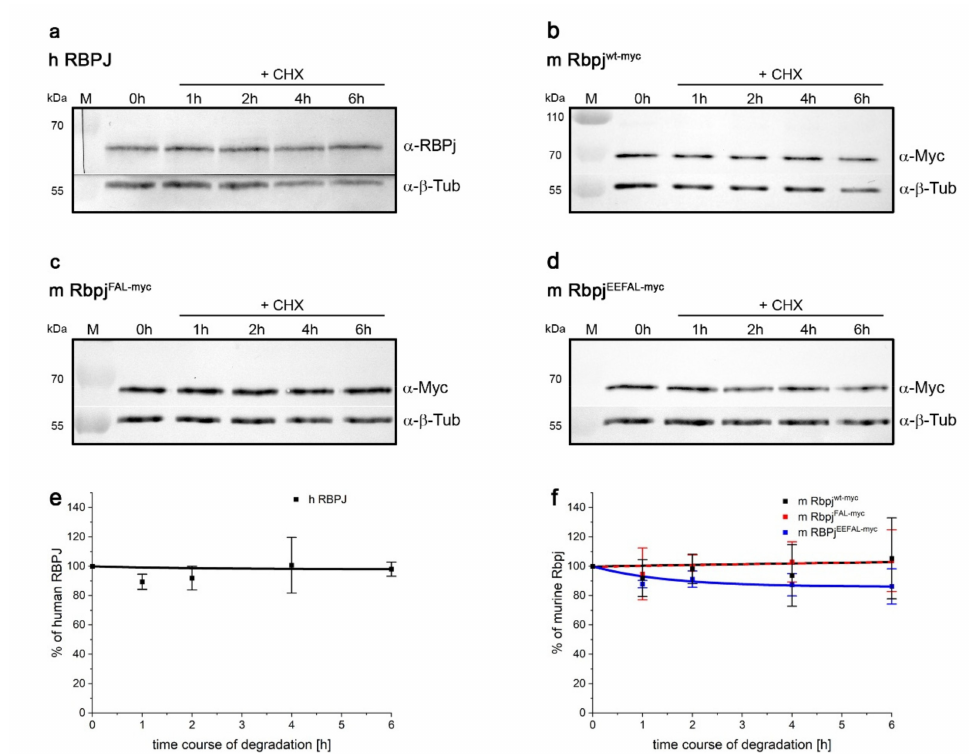
Figure 6. Stability of human RBPJ and mouse Rbpj proteins in HeLa RBPJ KO cells. Human RBPJ myc protein ( a ), mouse Rbpj wt-myc protein ( b ), Rbpj FAL-myc ( c ) and Rbpj EEFAL-myc ( d ), expressed in RBPJ KO HeLa cells. Translation was inhibited by addition of cycloheximide (CHX), and proteins extracted thereafter at the indicated time points. Human RBPJ was detected with anti-RBPSUH antibodies, and murine Rbpj variants based on the myc tag. Western blots were cut to monitor respective protein expression simultaneously with anti-beta-Tubulin ( β -Tub) for an internal standard. Representa- tive Western blots are shown. ( e , f ) Quantification of human RBPJ protein ( e ), and murine Rbpj protein variants ( f ) relative to beta-tubulin from three independent experiments performed under identical